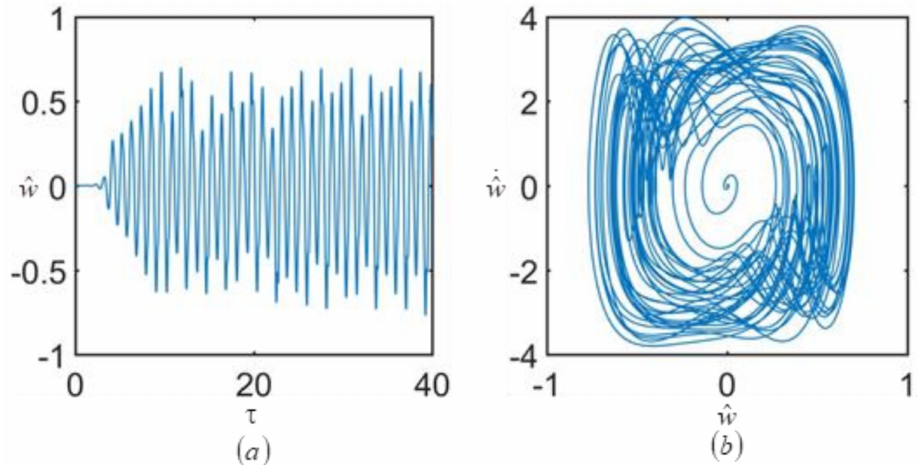
Figure 13. The linear response for the CFRP laminated cylindrical shell with an excitation frequency in the stable region: ( a ) the time history on the plane ( τ , ˆ w ) , and ( b ) the phase portrait on the plane . ( ˆ w , ˆ w ) .